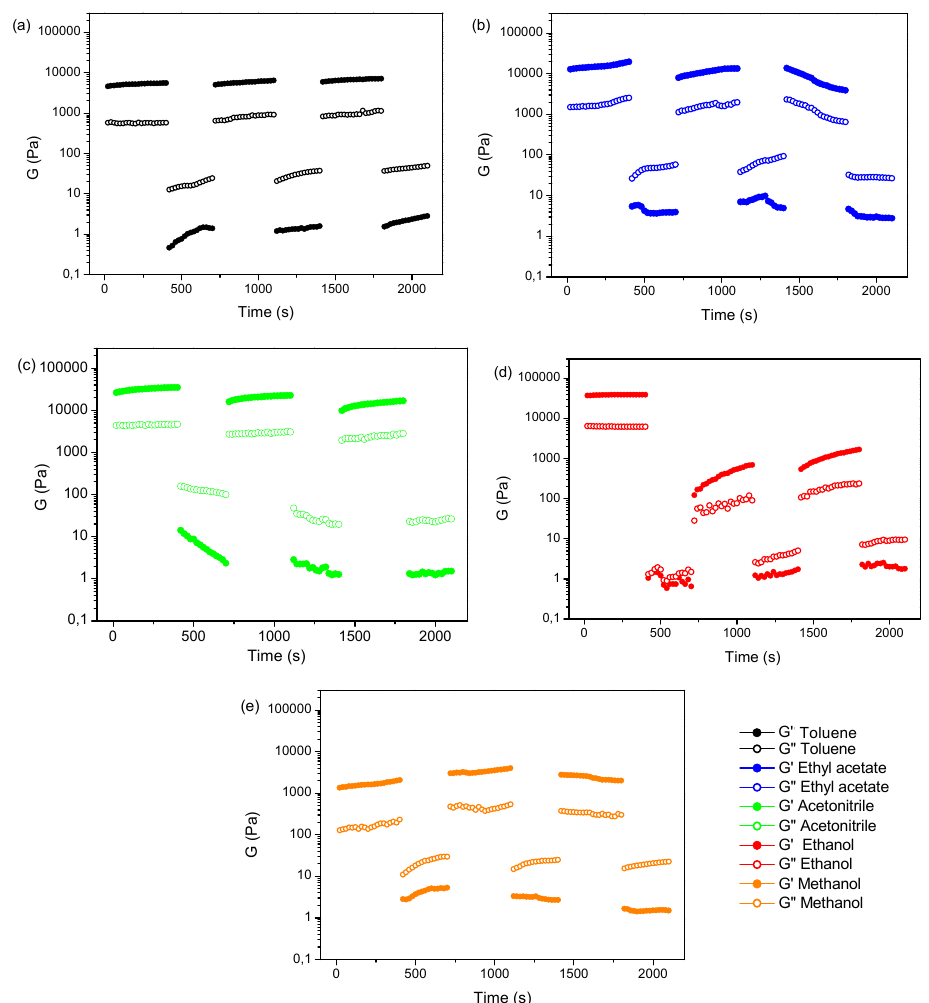
Figure 3. Values of storage moduli G ′ (solid circles) and loss moduli G ″ (empty cyrcles) recorded during step strain experiments performed on organogels in the solvent listed by increasing polarity: ( a ) toluene; ( b ) ethyl acetate; ( c ) acetonitrile; ( d ) ethanol; ( e ) methanol.